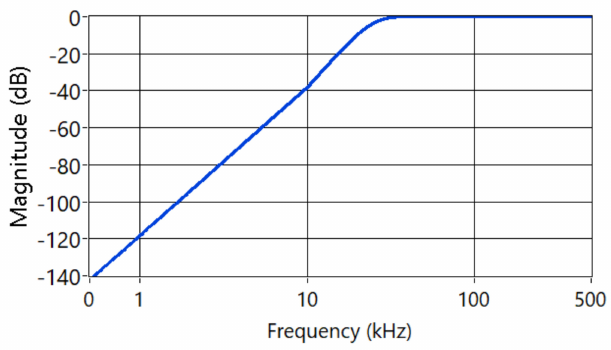
Figure 6. Magnitude response of the Butterworth filter applied to AE